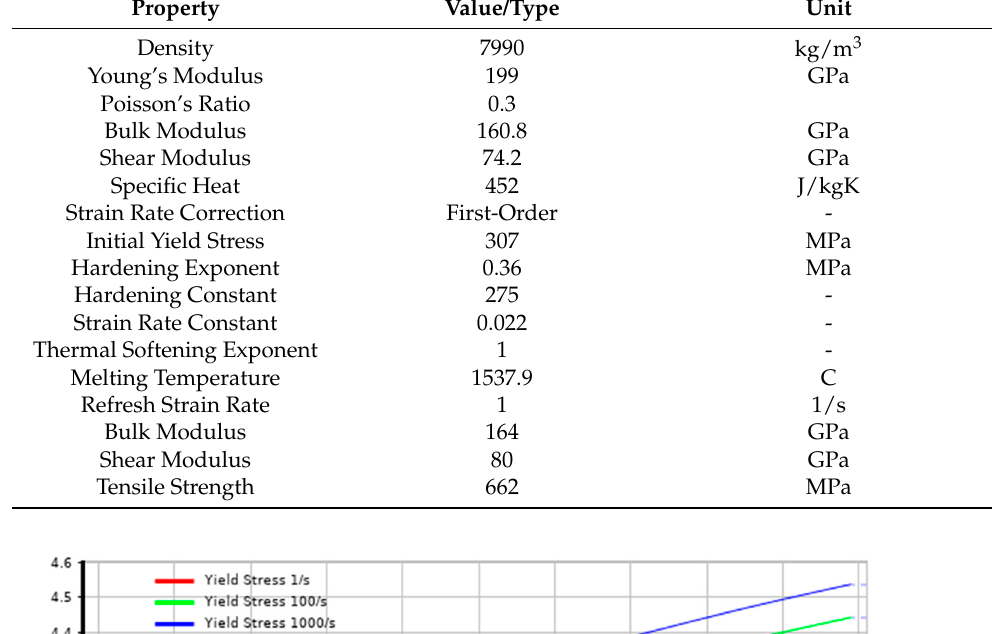
Table 2. The material properties of 316L steel used in numerical calculations.